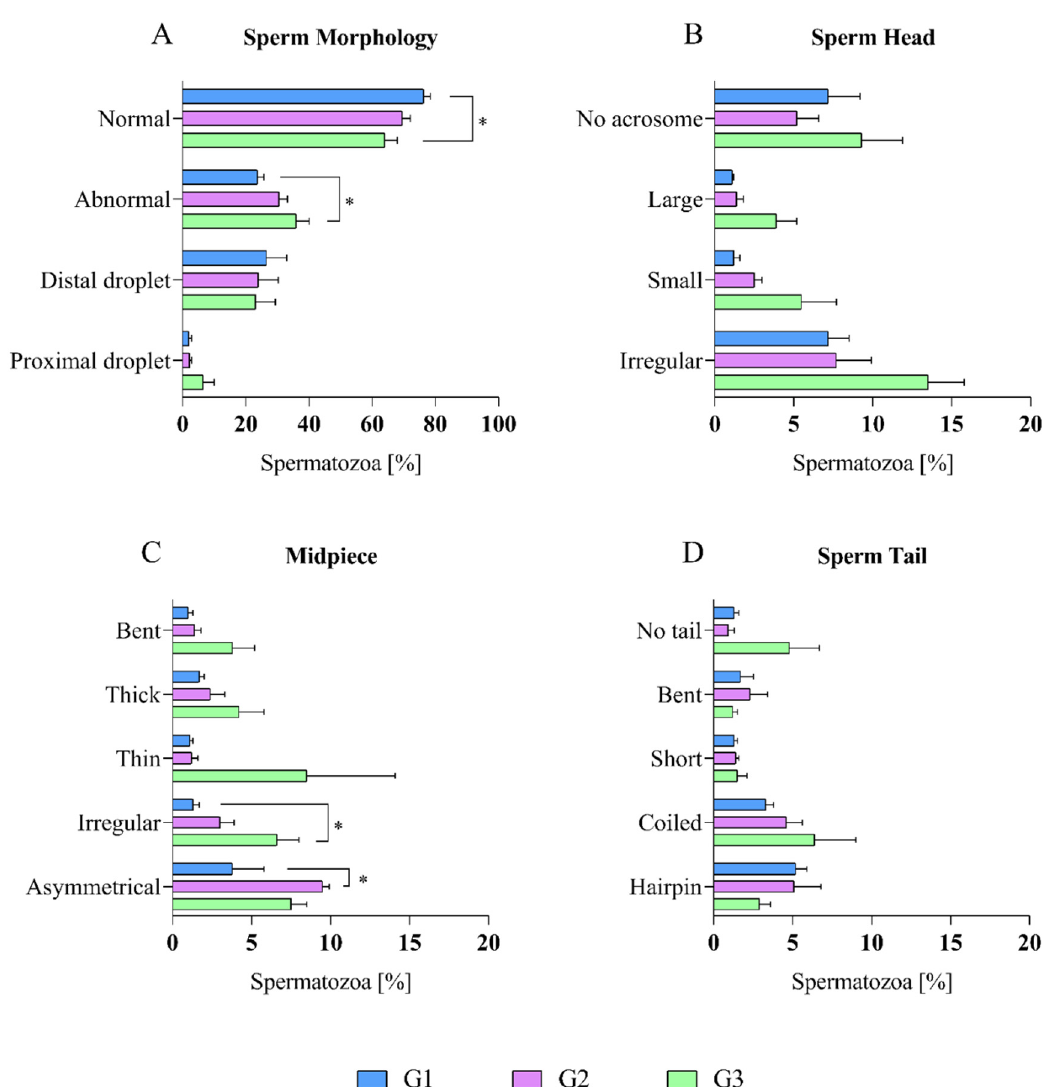
Figure 1. Morphological characteristics of the epididymal spermatozoa of dogs ( Canis lupus familiaris ) in different age groups (G1: 12–41 months old; G2: 42–77 months old; G3: 78–132 months old). The dog epididymal spermatozoa were stained with Spermac Stain™. ( A ) Sperm morphology was analysed according to the World Health Organization guidelines: normal (without primary defects), abnormal (at least one defect), sperm with distal droplet and sperm with proximal droplet. ( B ) Sperm head: no acrosome (sperm head without acrosome), large (sperm with large head), small (sperm with small head), irregular (irregular shape of sperm head). ( C ) Midpiece: bent, thick, thin, irregular (irregular shape of sperm midpiece), asymmetrical (asymmetrical position of sperm midpiece). ( D ) Sperm tail: no tail (sperm without tail), bent, short, coiled, harpin (harpin-like sperm tail). Values were given as the mean ± SE. * Significant at p < 0.05.